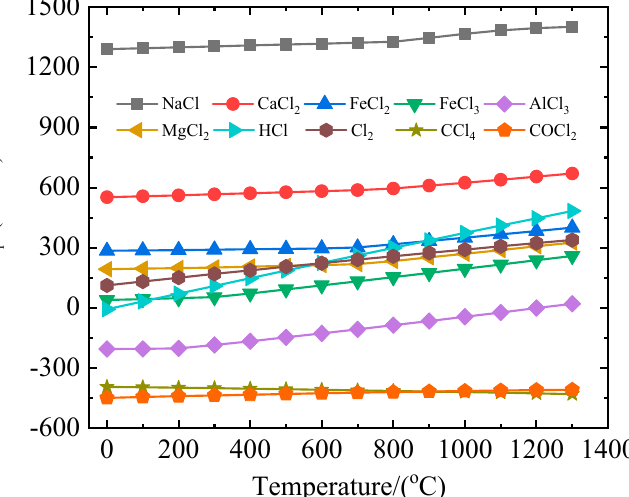
Figure 1. The standard Gibbs free energies of reactions between V 2 O 3 and chlorination agents (reactions 1–10).